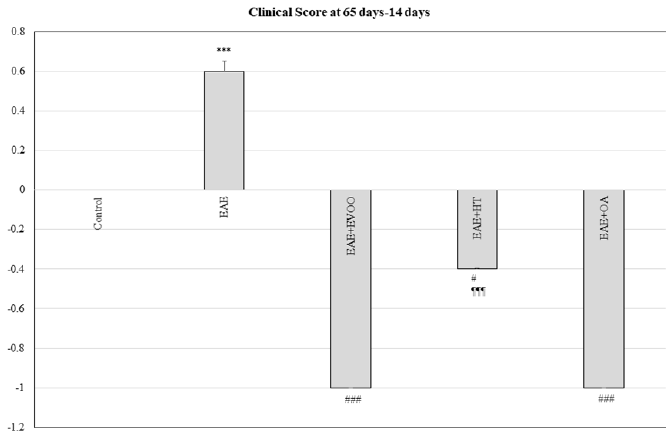
Figure 5. Clinical Score at 65 days less 14 days: The animals were monitored at 14 and 65 days and scored in accordance with the following severity scale: 0) no signs, 1) tail paralysis, 2 weakness in scored in accordance with the following severity scale: (0) no signs, (1) tail paralysis, (2) weakness in hind legs, (3) paralysis in hind legs, (4) paralysis in hind legs and weakness in front legs, and (5) quadriplegic [23,40]. The increase between the score at 65 days less the score at 14 days was established for the following study groups: control group (not manipulated); EAE group (experimental autoimmune encephalomyelitis induced by myelin oligodendrocyte glycoprotein (MOG)); EAE + extra-virgin olive oil (EVOO); EAE + hydroxytirosol group (HT); and EAE + oleic acid group (OA). *** p < 0.001 vs. control; # p < 0.05 vs. EAE; ### p < 0.001 vs. EAE; ¶¶¶ p < 0.001 vs. EAE +